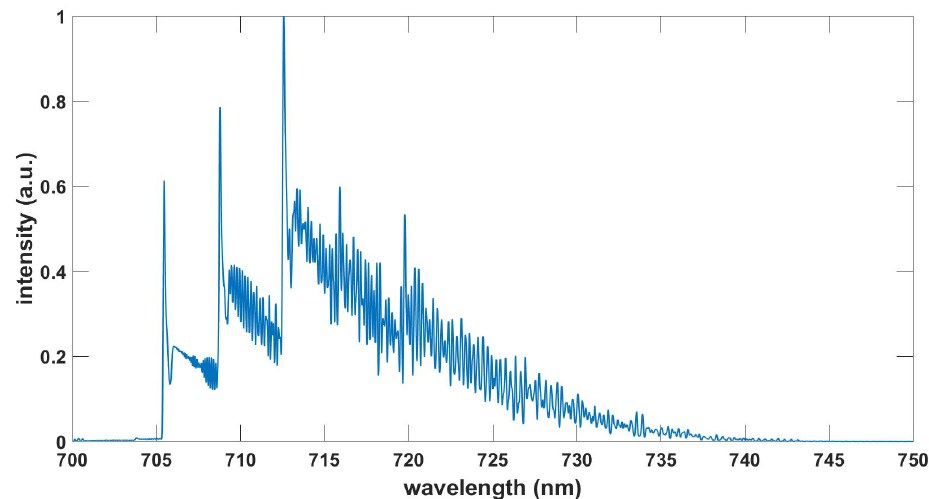
Figure 8. Computed TiO γ spectrum, ∆ v = 0, δ λ = 0.10nm, T = 3.03 kK.